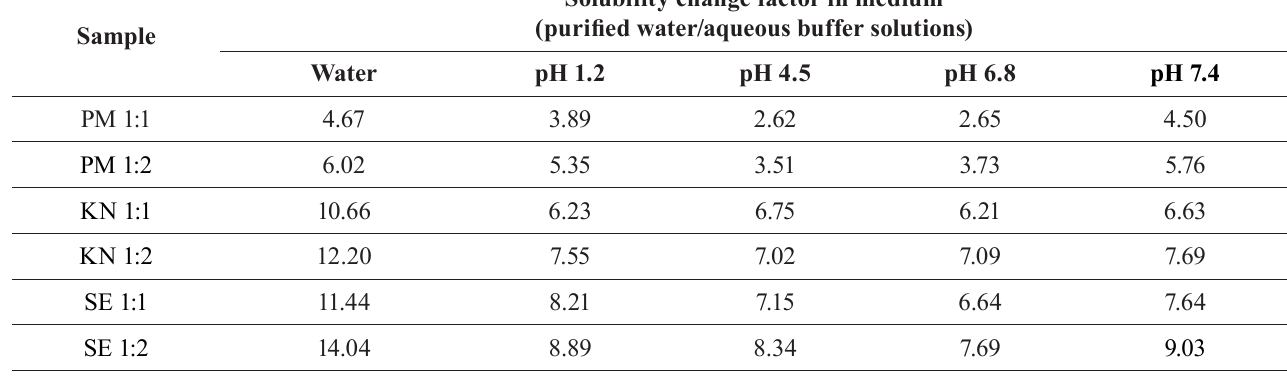
TABLE IV - Solubility change factor of binary physical mixtures and inclusion complexes of CPHC with 2-HP-β-CD in purified water and aqueous buffer solutions at 37 o C ± 0.1 o C Solubility change factor in Sample